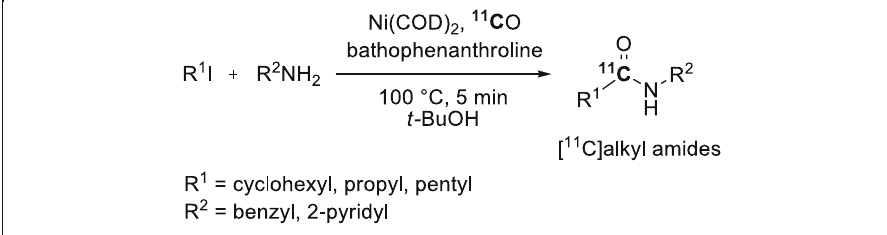
Fig. 16 Ni(0)-Mediated cross-coupling reaction of non-activated alkyl iodides bearing a β -hydrogen atom. Ni(COD) 2 =